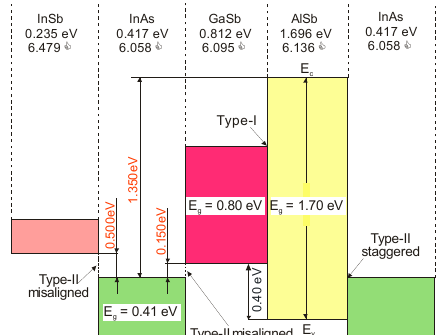
Figure 7. Schematic diagram of the low-temperature energy band alignment in the nearly 6.1 Å lattice matched InAs/GaSb/AlSb compounds. In this material system three types of band alignment are possible: type-I (nested) band alignment between GaSb and AlSb, type-II staggered alignment between InAs and AlSb, and type-II misaligned (or broken gap) alignment between InAs and GaSb. The approximate values of band offsets are marked in red.